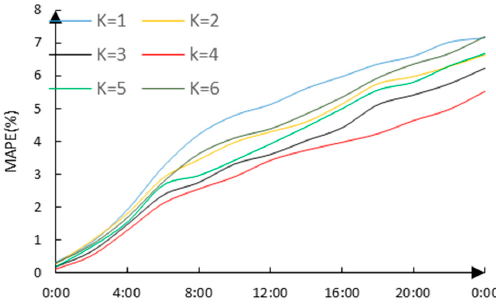
Figure 8. The variation curves of MAPE under different clustering conditions in experiment C.